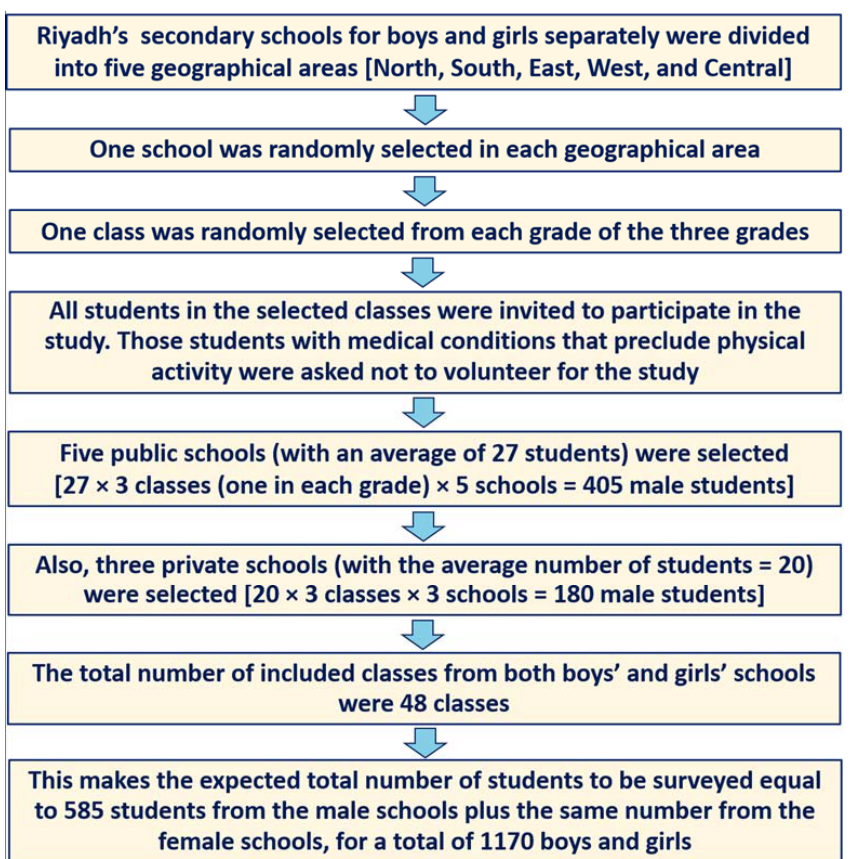
Figure 1. Flowchart showing the process of the students’ selection.